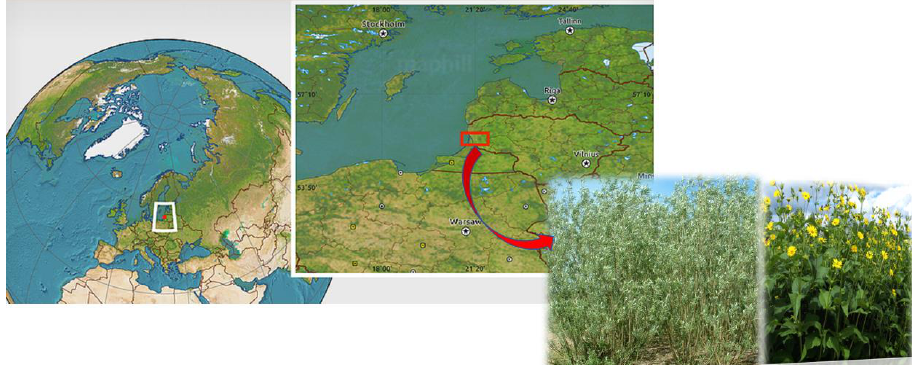
Figure 1. The field experimental site.